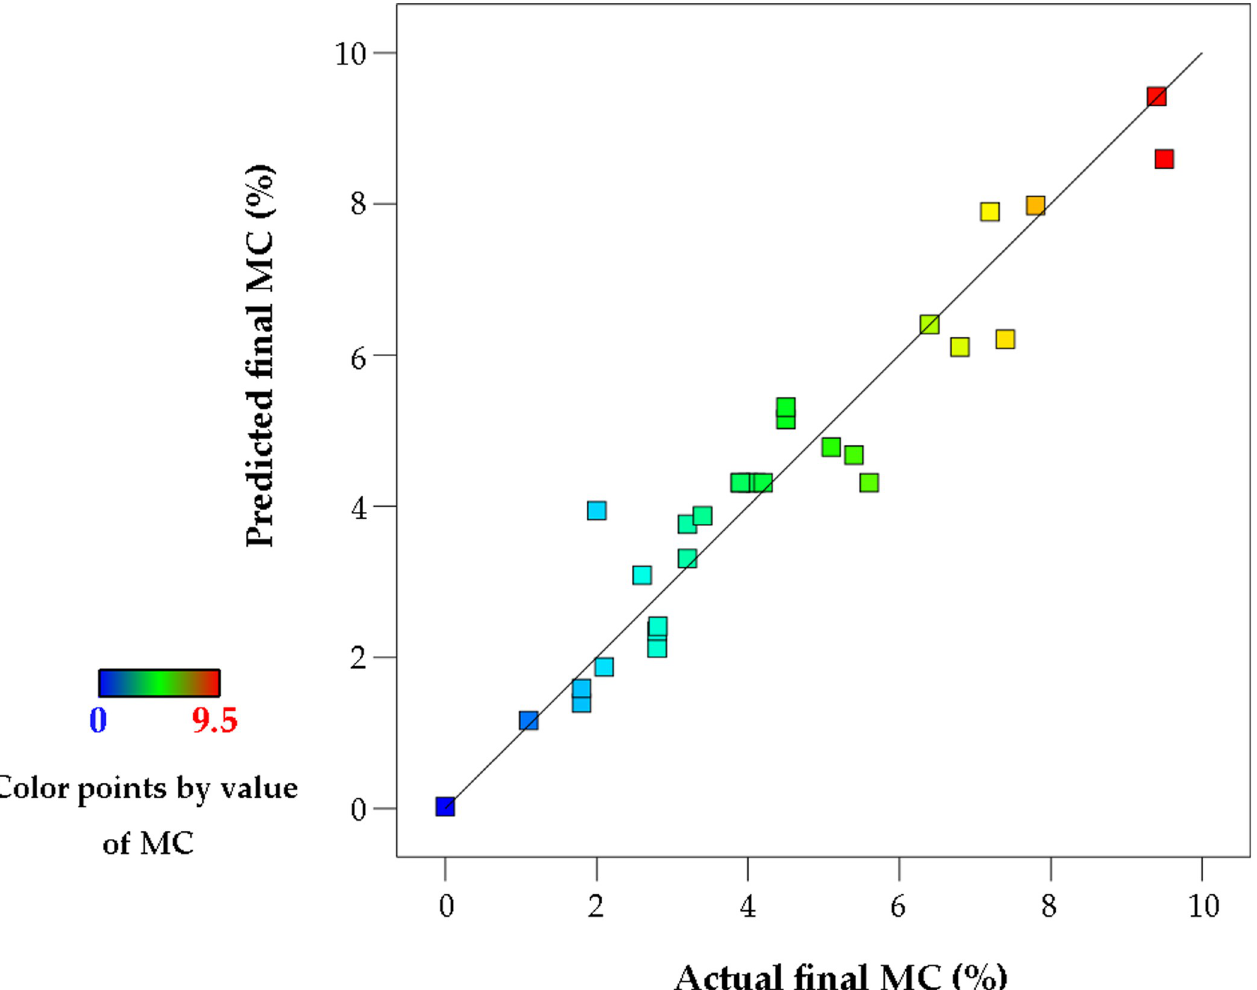
Fig 12. Predicted versus actual final MC